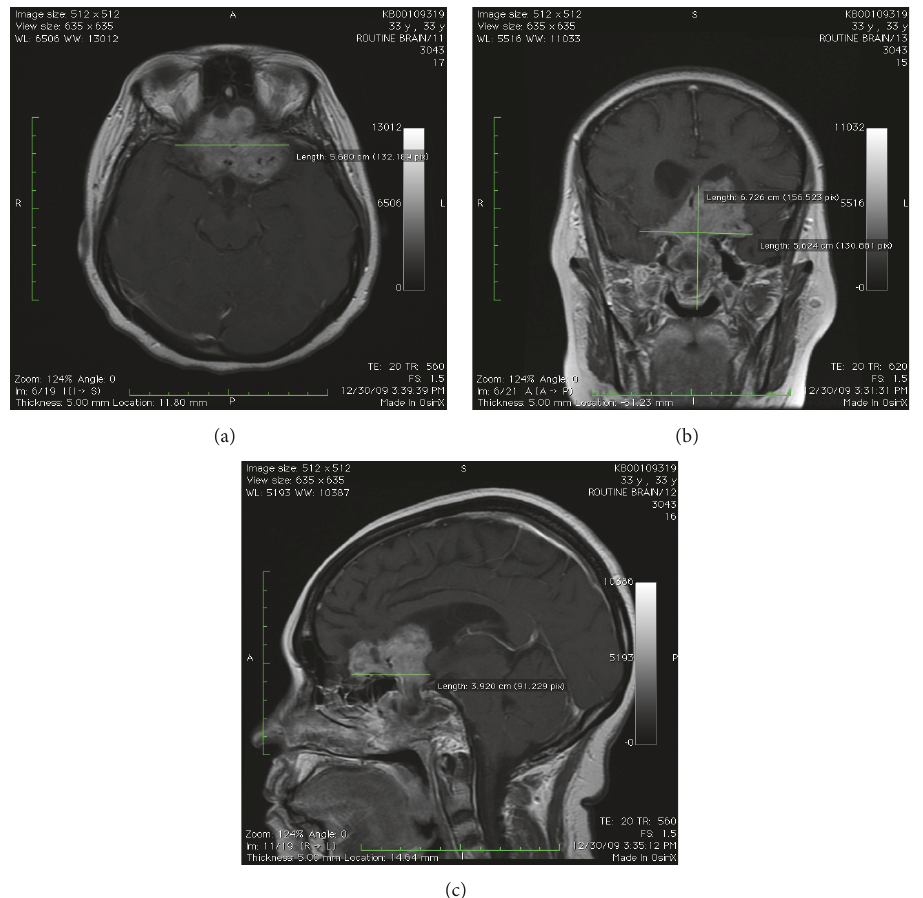
Figure 2: Contrast enhanced axial (a), coronal (b), and sagittal (c) T1-weighted sequence on MRI at 12-month follow-up showing reduction in size of the pituitary macroadenoma following treatment with